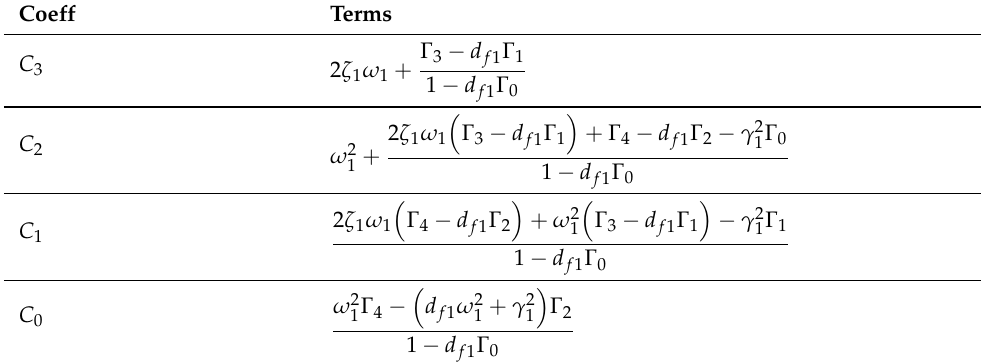
Figure 1. Block diagram structures for damping ( a ) and damping with tracking ( b ), respectively. Here, r , e , u , y and y d represent the reference, error, control input, output and modified output, respectively. G T ( s ) , G ( s ) and C PFC ( s ) are the tracking controller, plant and positive feedback controller, respectively. Table 1. Denominator coefficient table.